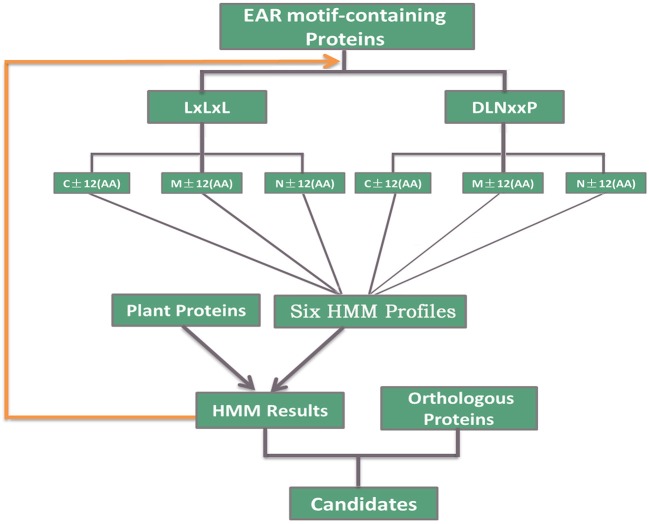
Description of the identification of EAR motif-containing proteins. A total of 219 high-confidence EAR motif-containing proteins in Arabidopsis were divided into six subgroups according to the EAR motif pattern (LxLxL, DLNxxP) and the location of the EAR motif (C-terminal, Middle, N-terminal). Iterated HMM was used to identify the EAR motif-containing proteins that would later be filtered with the EAR pattern in each iteration. Inparanoid software was also used to identify the orthologous proteins of 398 Arabidopsis EAR motif-containing proteins. Then, we took both HMM and inparanoid tool results with the EAR pattern into consideration and defined the EAR motif-containing protein candidates in plants.